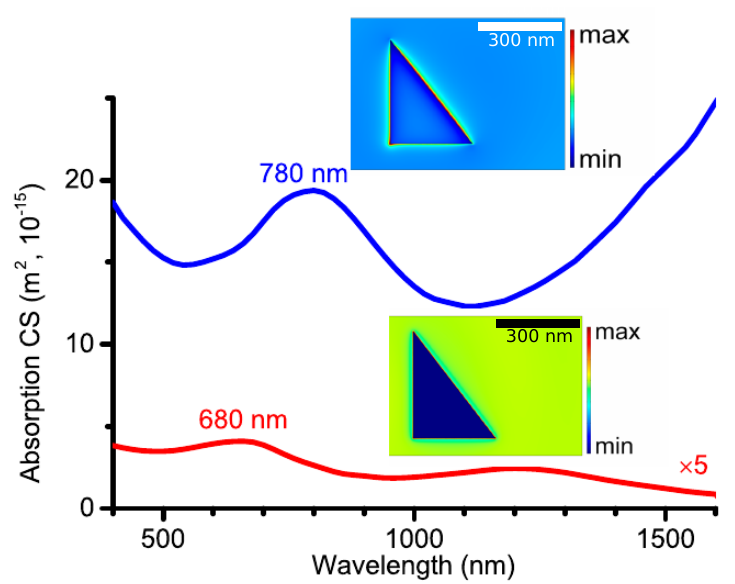
Figure 5. Simulated absorption CS of 7.5 nm thick triangular Ti 3 C 2 T x sheet with side lengths 300, 400 and 500 nm. For the ease of modeling, the triangles are capped at corners by arcs of 2 nm curvature radius. Incident electric field is: perpendicular (TM polarization, red curve) and parallel (TE polarization, blue curve) to the plane of sheet being perpendicular to the hypotenuse. Insets: electric field intensity maps placed above each curve, at the excitation wavelengths of 680 nm for the red one, and 780 nm for the